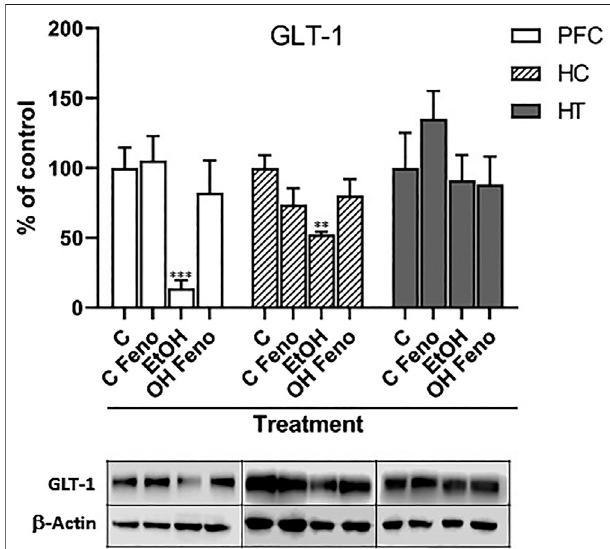
FIGURE 2 | Expression levels of GLT-1 in prefrontal cortex (PFC), hippocampus (HC) and hypothalamus (HT) in rats that were administered alcohol for one month and then were treated with feno fi brate for 14 days. C (cid:1) water-administered controls; C Feno (cid:1) water-administered controls treated with feno fi brate; EtOH (cid:1) alcohol-treated rats; EtOH Feno (cid:1) alcohol- treated rats then treated with feno fi brate. The graphs show the protein levels expressed as percentages of their water-administered controls, normalized by the levels of ß -actin. Representative blots from each group are shown below each respective bar. ANOVA ** p < 0.01; *** p < 0.001. PFC: F (3,12) (cid:1) 14.81 for EtOHeffect;HC:F (3,12) (cid:1) 6.39forEtOHeffect.TheerrorbarscorrespondtoSD, n (cid:1) 4. The absolute values, normalized by ß -actin, obtained from the quanti fi cation of the bands are: PFC (C (cid:1) 1.30 ± 0.44; C FENO (cid:1) 1.37 ± 0.11; EtOH (cid:1) 0.18 ± 0.10;EtOHFENO (cid:1) 1.07 ± 0.12);HC(C (cid:1) 0.61 ± 0.21;CFENO (cid:1) 0.45 ± 0.05; EtOH (cid:1) 0.32 ± 0.08; EtOH FENO (cid:1) 0.49 ± 0.06); HT (C (cid:1) 0.34 ± 0.12; C FENO (cid:1) 0.51 ± 0.03; EtOH (cid:1) 0.31 ± 0.05; EtOH FENO (cid:1) 0.30 ±